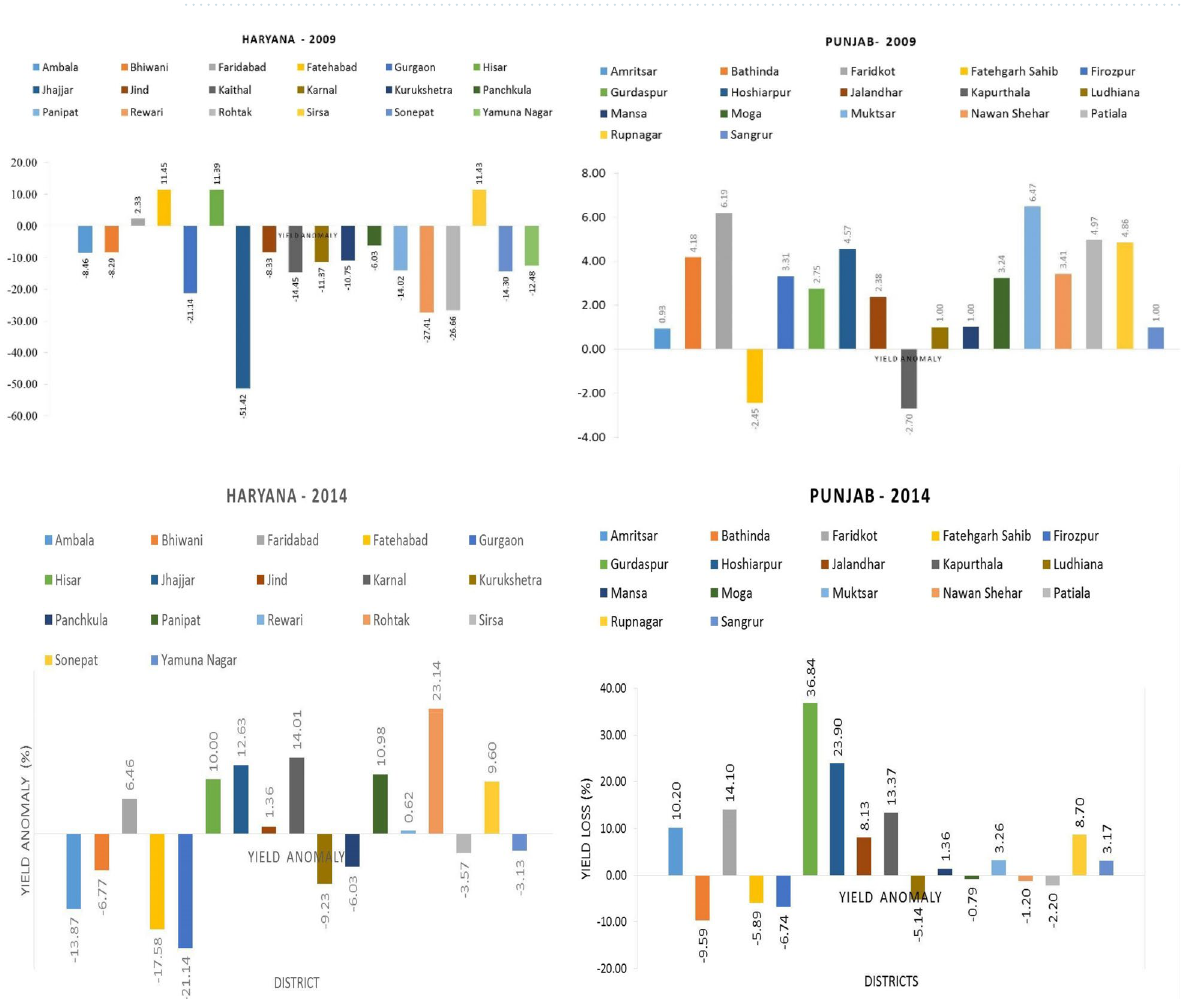
Figure 11. Annual anomaly of rice productivity (%) in different districts of Punjab and Haryana for 2009 and